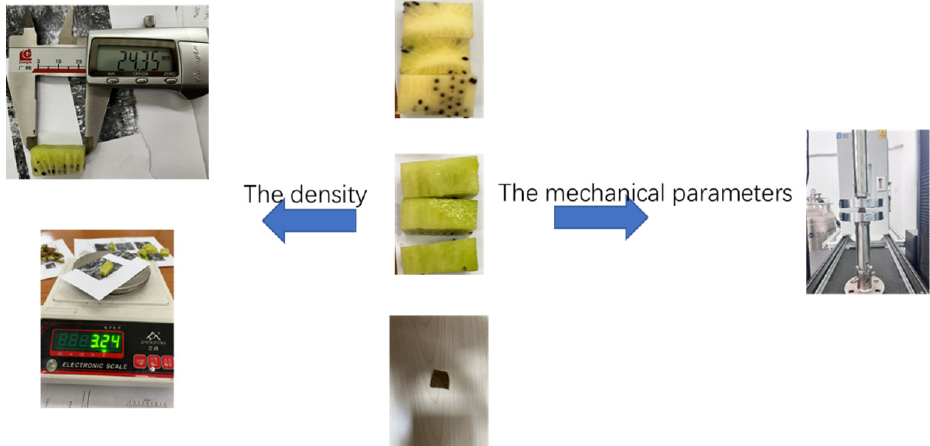
Figure 1. Schematic diagram of the parameters being obtained.